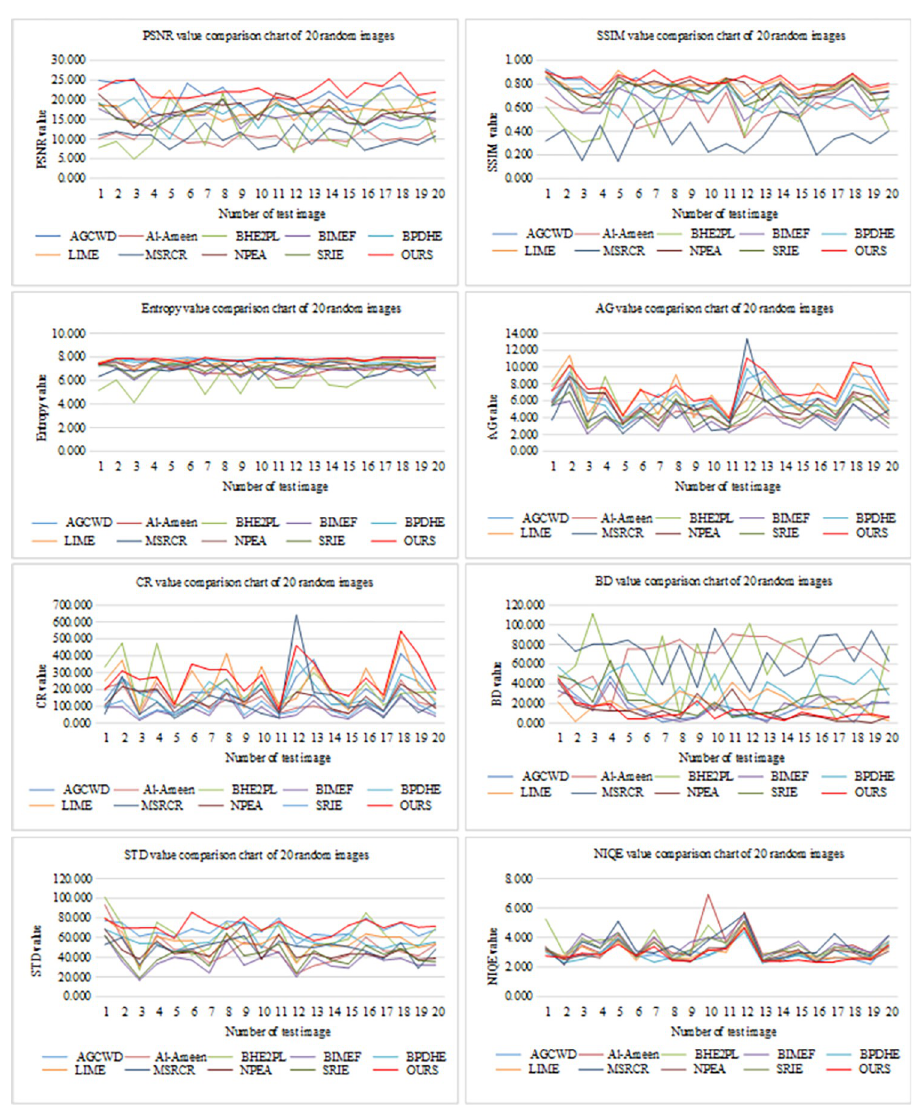
Fig 31. 20 random images with different method score line graphs for each index value.